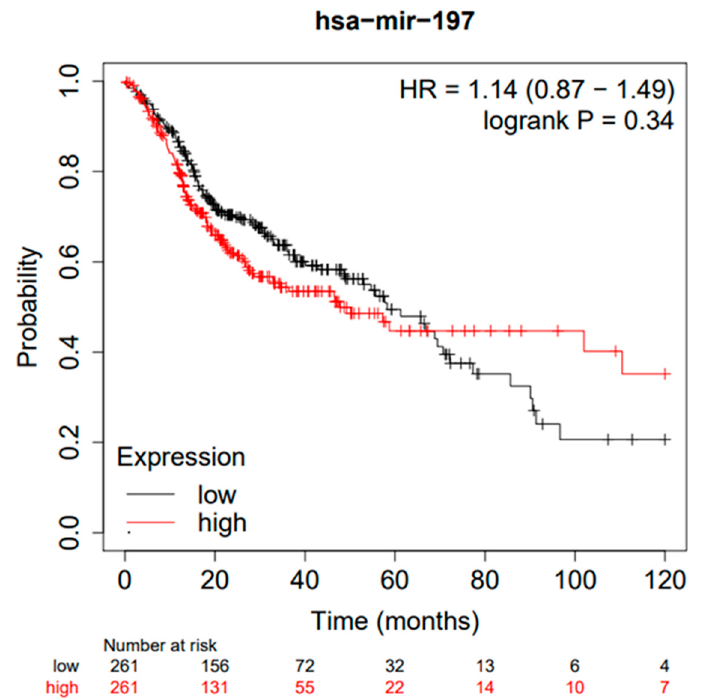
Figure 2. Kaplan–Meier curves according to the miR-197 expression levels for overall survival (OS) of patients with HNSCC (TGCA cohort). Kaplan–Meier curves created by the public database and web application Kaplan–Meier plotter (http://kmplot.com/analysis/, accessed on 1 August 2022). When performing a further analysis after a follow-up period of 60 months, the data became more strongly in favor of a worsening prognosis in the presence of a high expression of miR-197, with an HR of 1.48 (1.12–1.97) (Figure 3).